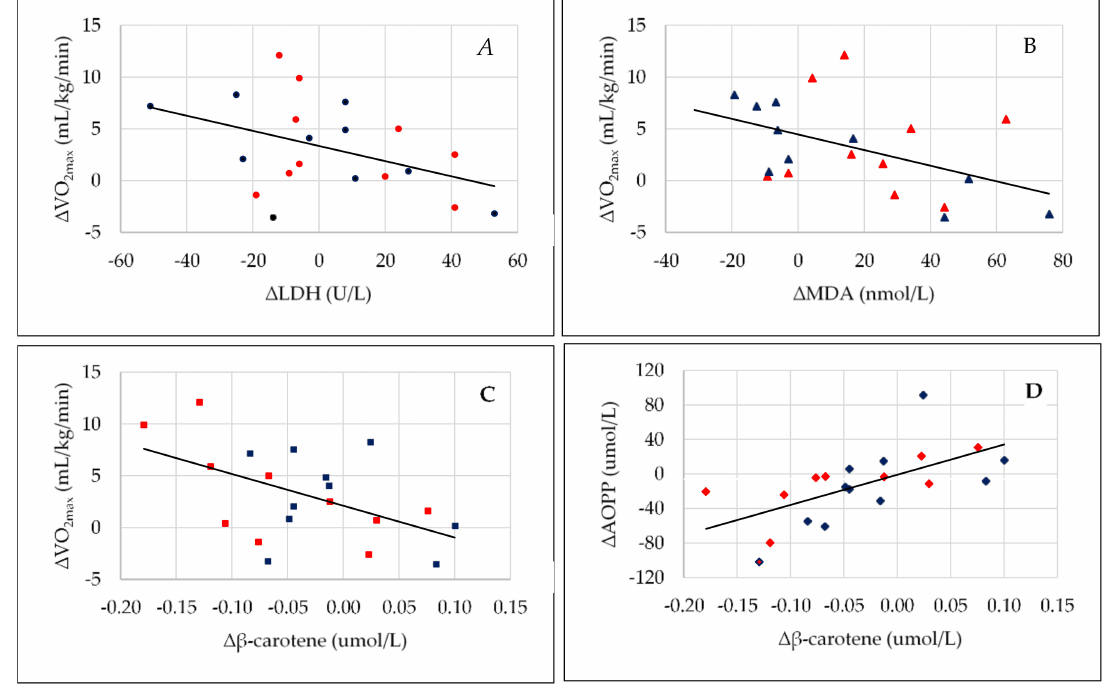
Figure 3. ( A – D ). The relationship between changes of VO2max and changes of: LDH ( A ), MDA ( B ), and β -carotene ( C ), (r = − 0.518, p = 0.028; r = − 0.472, p = 0.036; r = − 0.500, p = 0.029—respectively) as well as changes of β -carotene with changes of AOPP ( D ) (r = –0.500, p = 0.029). Red markers—women, blue markers—men. Changes were calculated as the di ff erence between the absolute values after ID&BEET (implementation of dietary recommendations and beetroot juice supplementation) minus the values after ID (implementation of dietary recommendations). VO2max: Maximum rate of oxygen uptake; MDA: Malondialdehyde; LDH: Lactate dehydrogenase; AOPP: Advanced oxidation protein